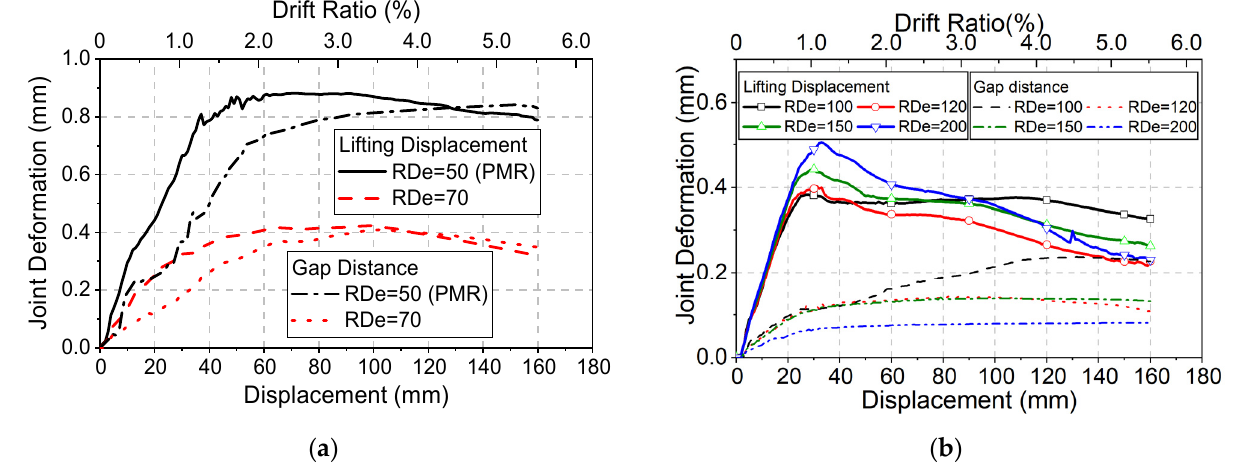
Figure 19. Joint deformation with different recess depths: ( a ) RDe ≤ 70 mm; ( b ) RDe ≥ 100 mm.